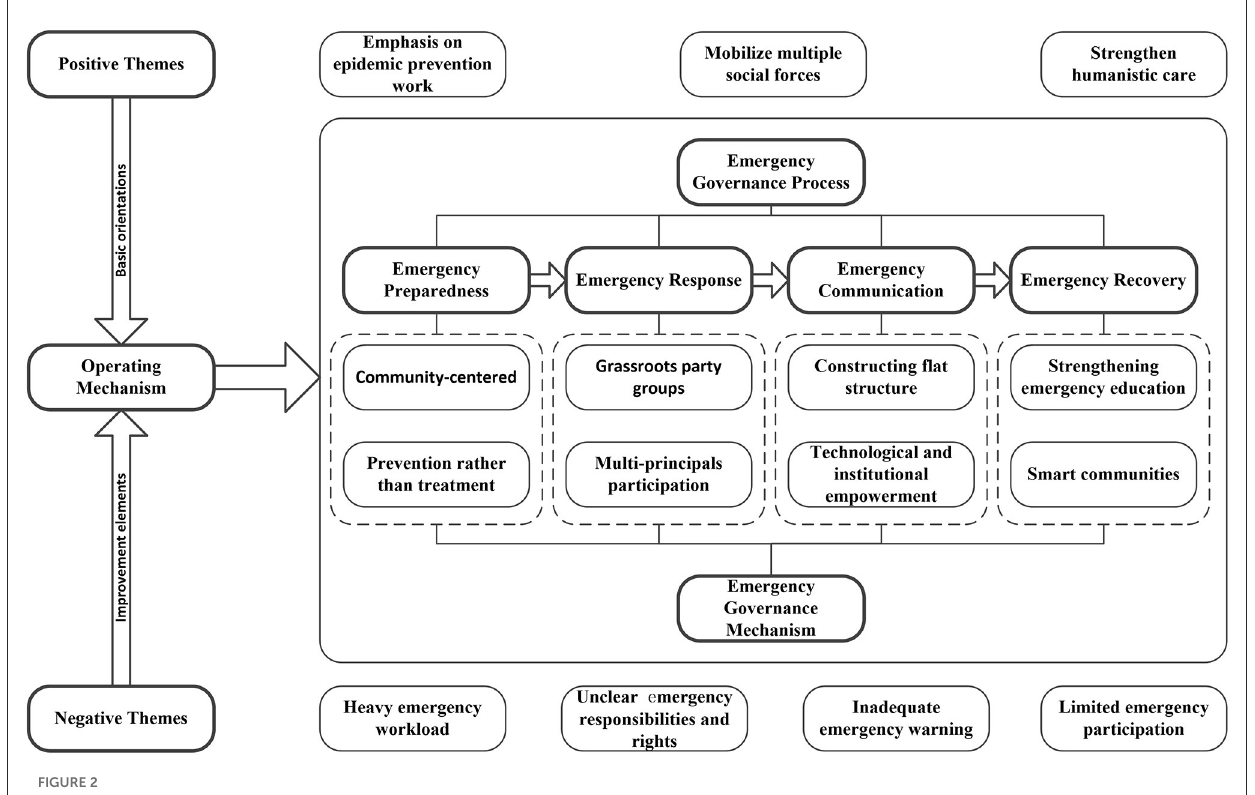
FIGURE2 Mechanism innovation of community emergency